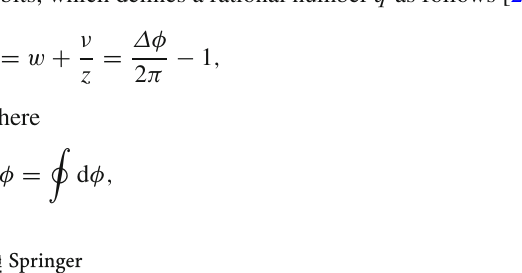
orbits, which defines a rational number q as follows